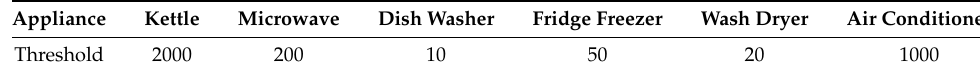
Table 1. Power-on threshold for each